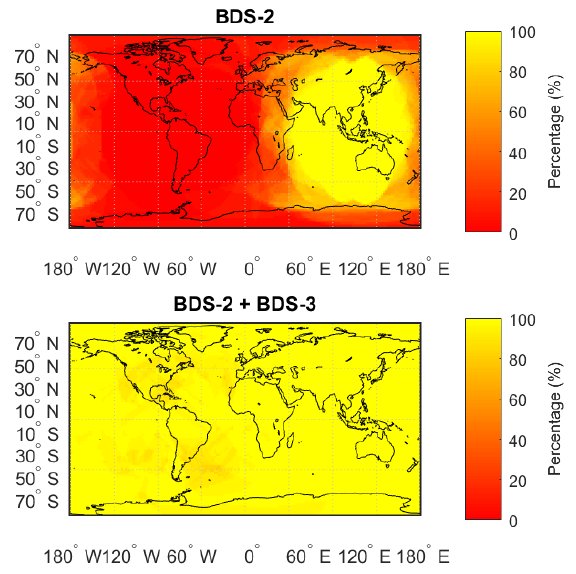
Figure 3. PDOP availability (PDOP < 6) for BDS-2 ( upper ) and BDS-2 + BDS-3 ( lower ) for an elevation angle mask of 10°on 1 January 2019.